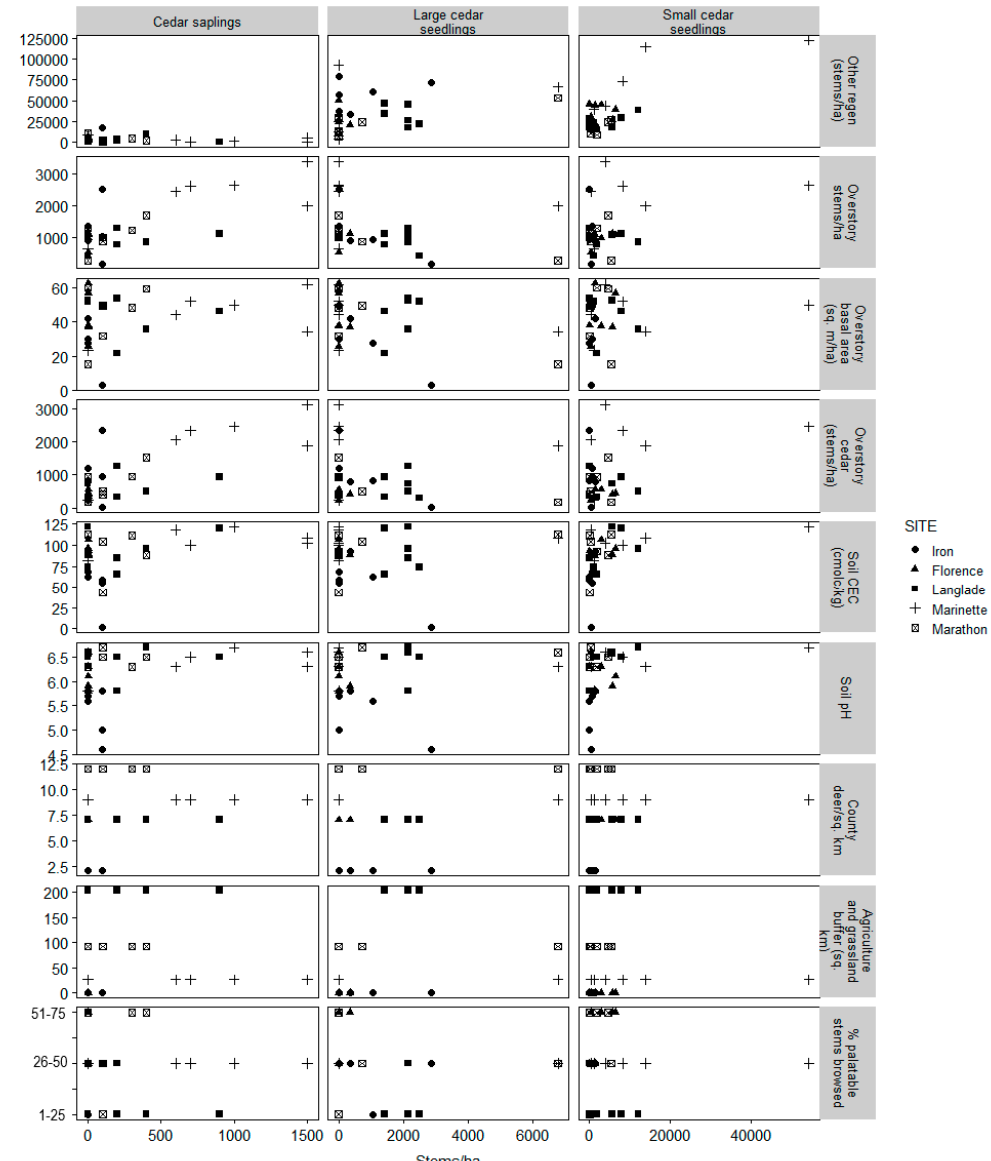
Figure 3. White-regeneration in three height classes versus variables tested as model parameters in at least one model. Saplings were 1.83 m tall to less than 10 cm dbh, large seedlings were 20 cm to < 1.83 m tall, and small seedlings were less than 20 cm tall. Note that y-axes differ in each row. In the first row, white-cedar regeneration is compared to regeneration of other woody species (trees and shrubs) in the same height class.